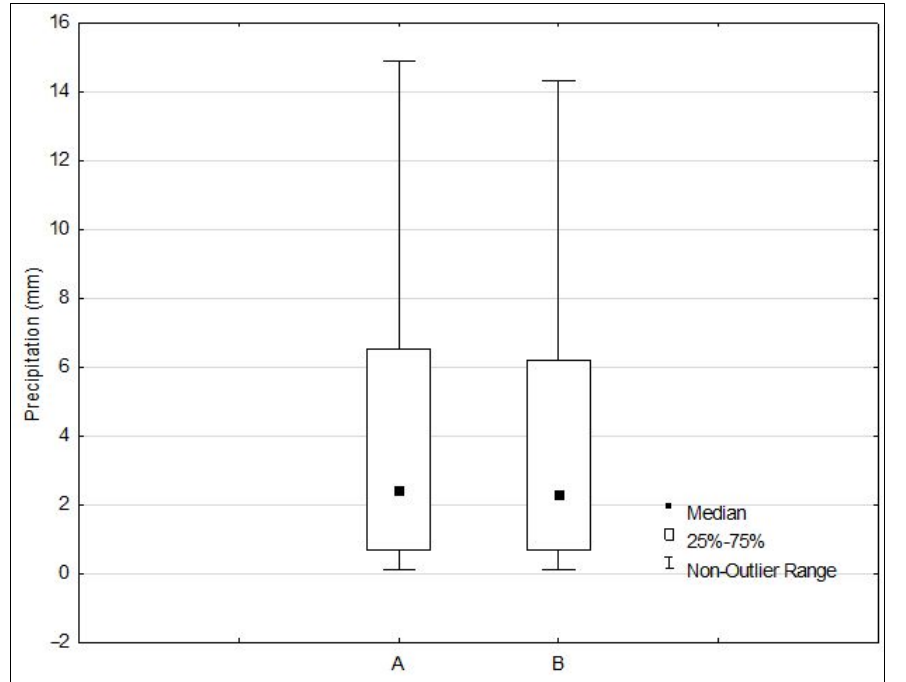
Figure 5. Mean Values of actual precipitation ( A ) and climatic precipitation ( B ).